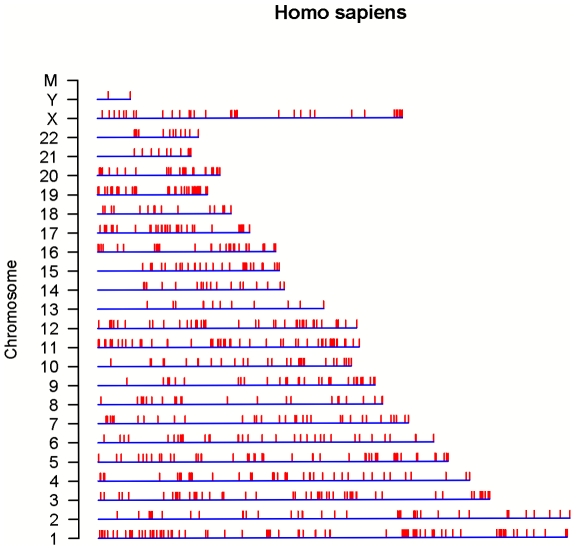
Genome-wide screening with the functional AutRef84 profile.The functional profile of AutRef84 was used to predict ASD genes and map them to their appropriate location on the chromosome. To perform this data mining, we used the biomaRT package of Bioconductor from human genome at the Ensembl database (http://www.ensembl.org/Homo_sapiens) to create a graphical representation of chromosomal locations of genes matching with the functional AutRef84 profile. The complete list of 1185 matching genes is provided as Table S7. This map indicates uneven distribution with dense packing of matched genes in discrete chromosomal regions, 13 of which reached statistical significance (Table S8).